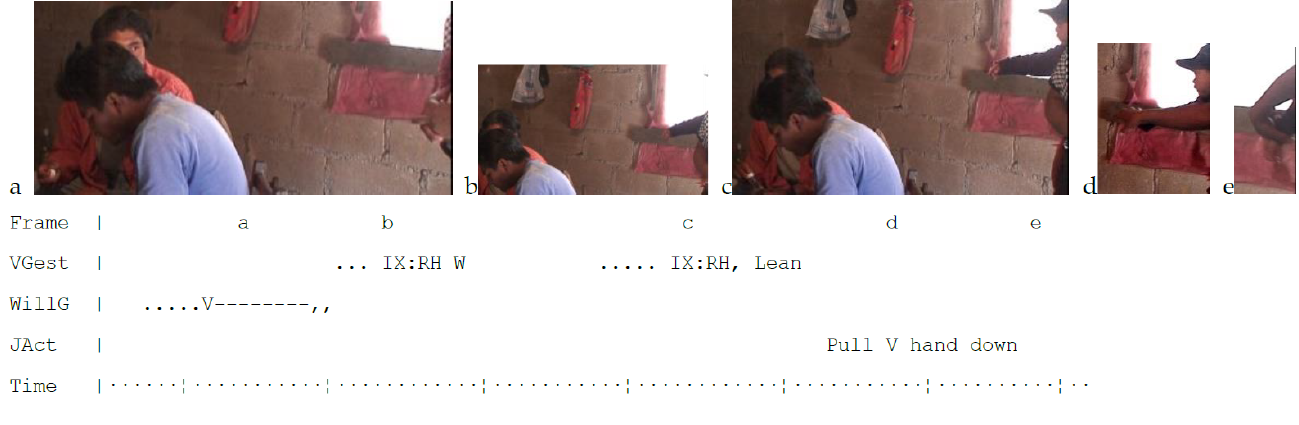
Figure 6. Vic at 11 mos. pointed at Will and was restrained. ( a ) Will had glanced up to meet Vic’s gaze, establishing apparent brief eye contact. ( b ) Vic’s raised “pointing” hand appeared. ( c ) Vic repeated the pointing gesture insistently a second time. ( d ) Jane reached up quite deliberately, ( e ) to pull his hand down.